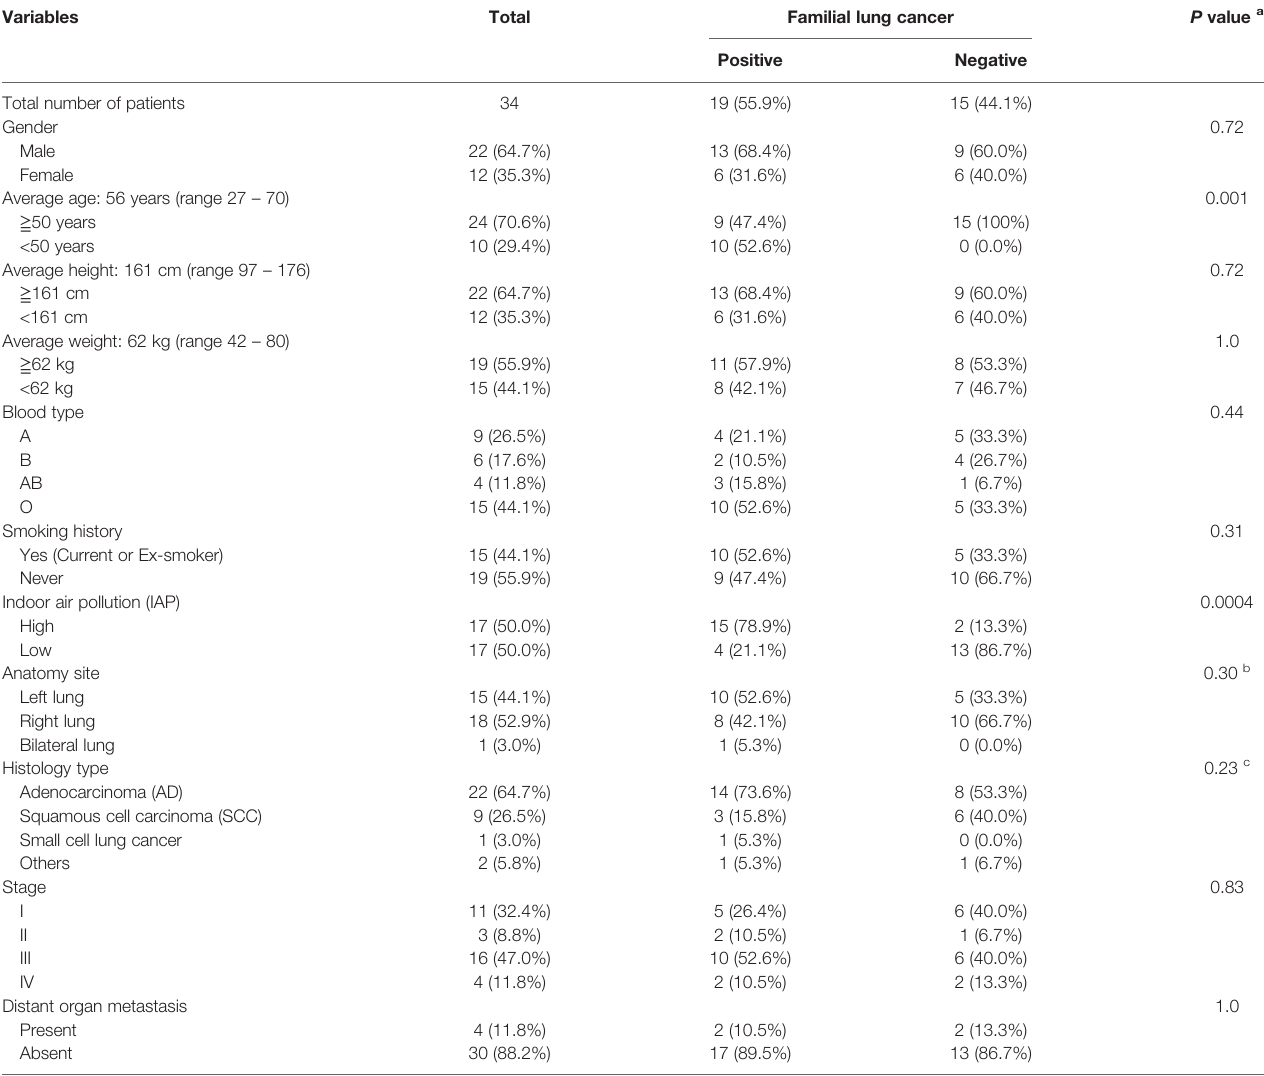
TABLE 1 | Clinicalpathological characteristics of 34 lung cancer patients divided by